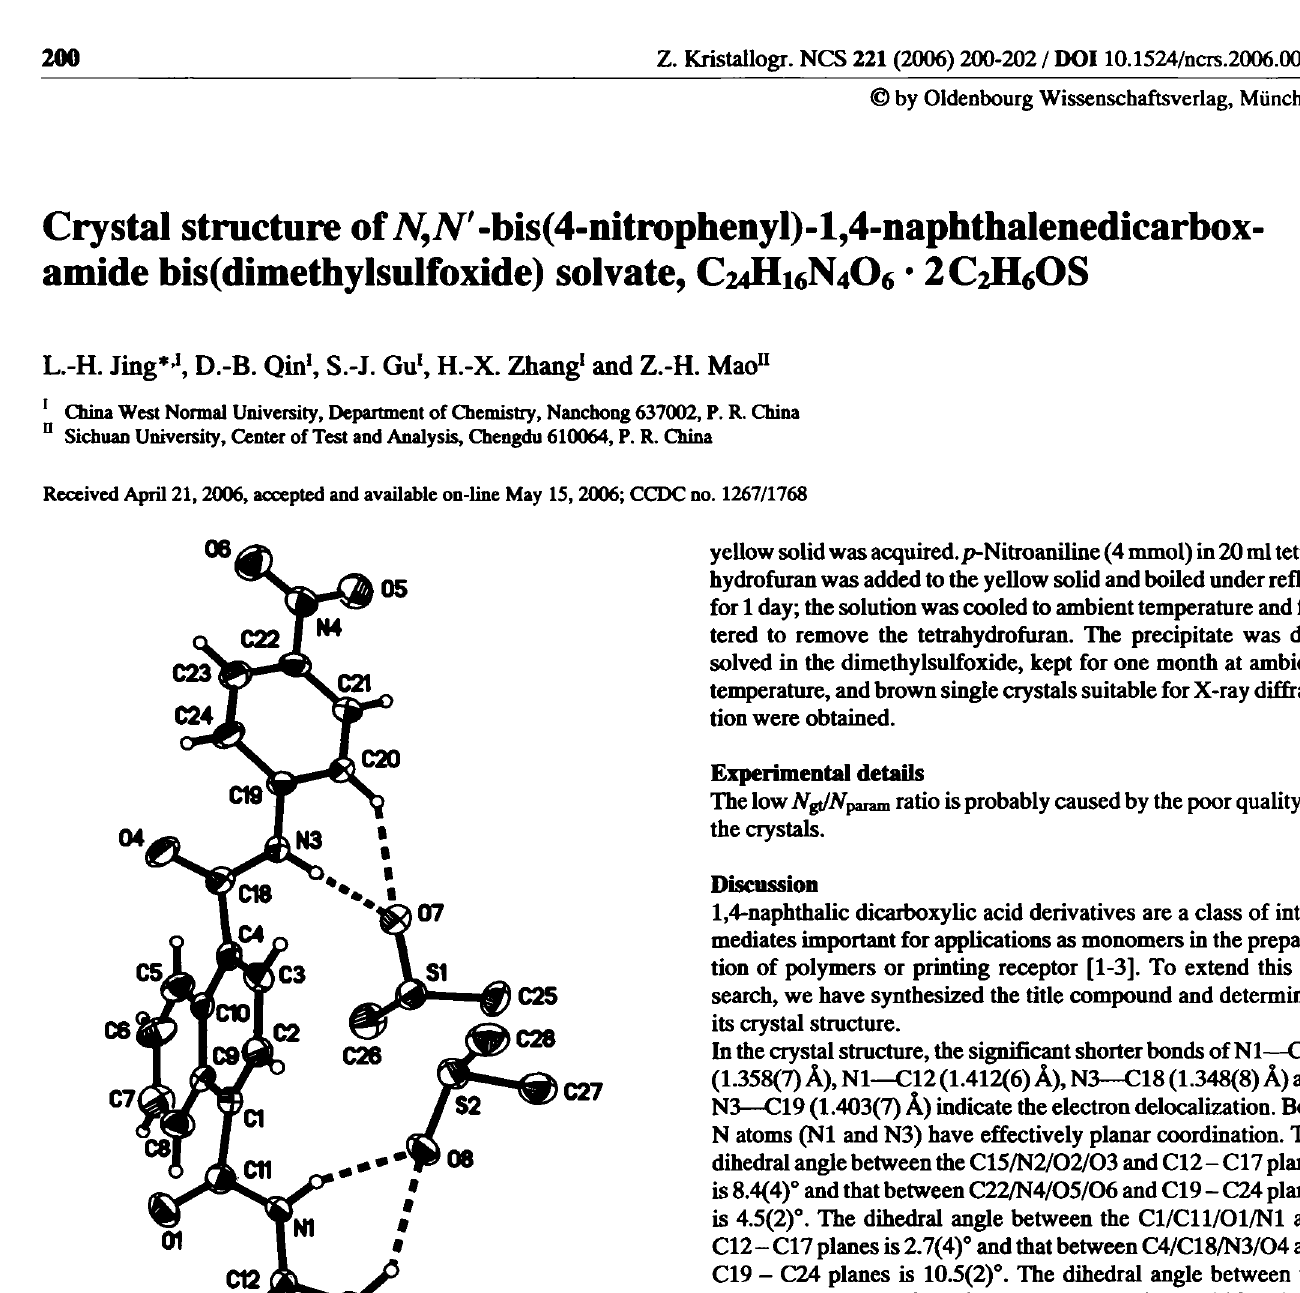
Table 1. Data collection and